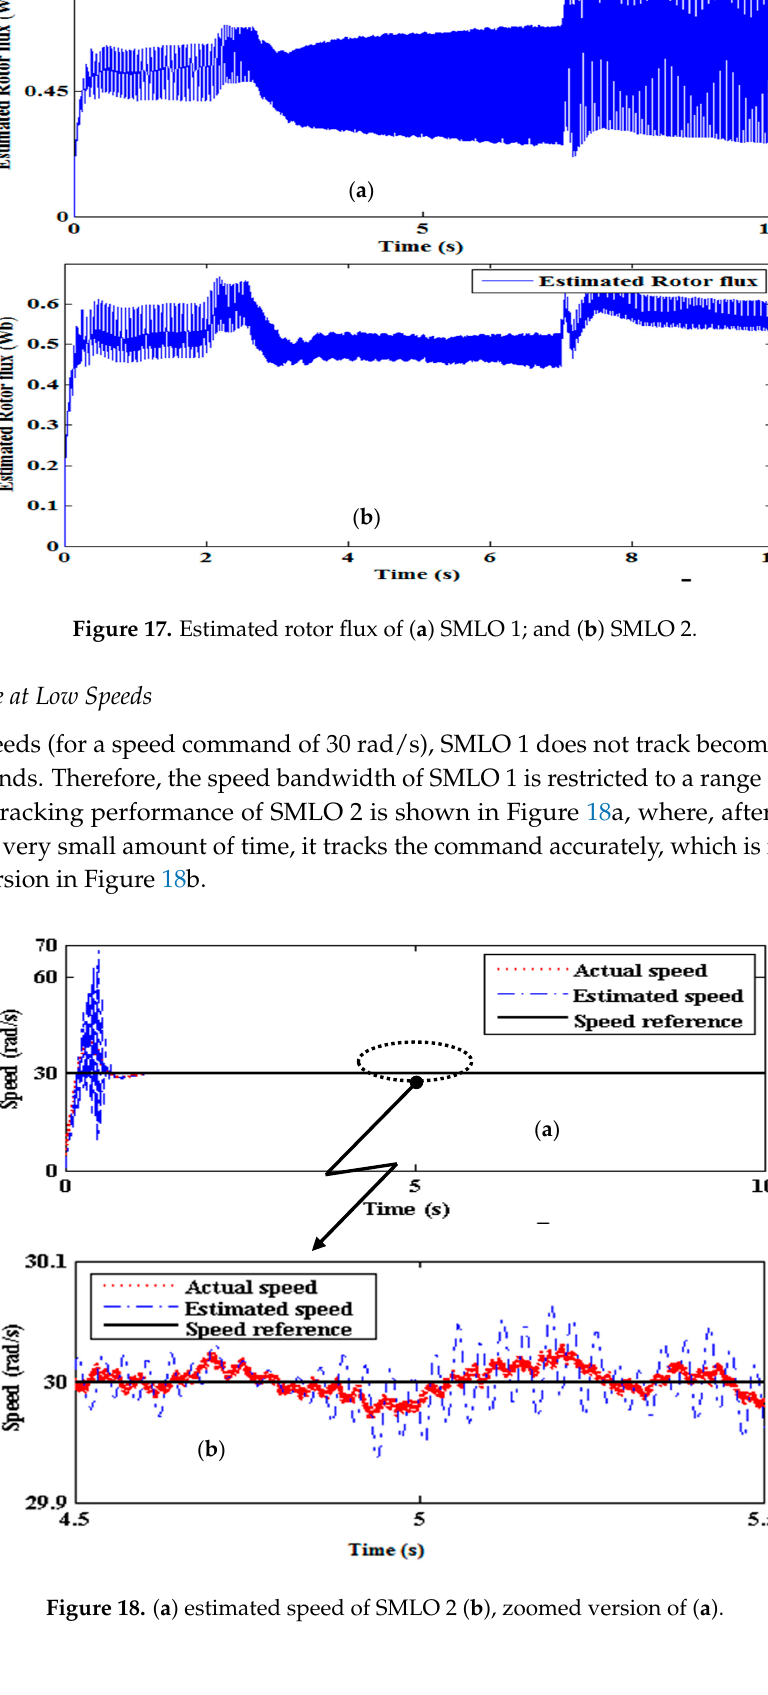
Figure 16. Estimated disturbance torque of ( a ) SMLO 1; and ( b ) SMLO 2.